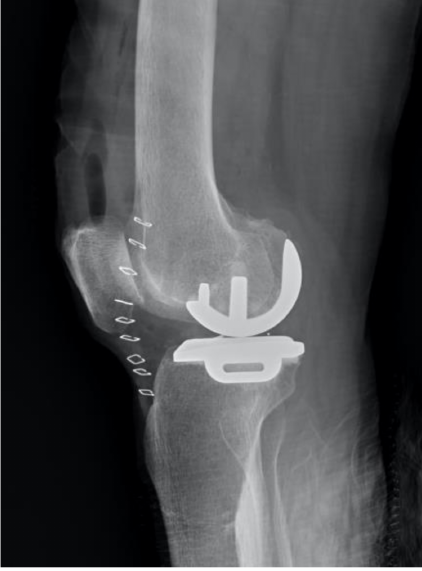
Figure 1. A postoperative lateral view of the femoral component underhang.